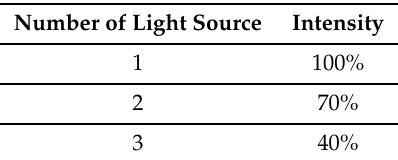
Figure 26. Virtual mouse on bottom left side compared with real ones. Table 1. Light